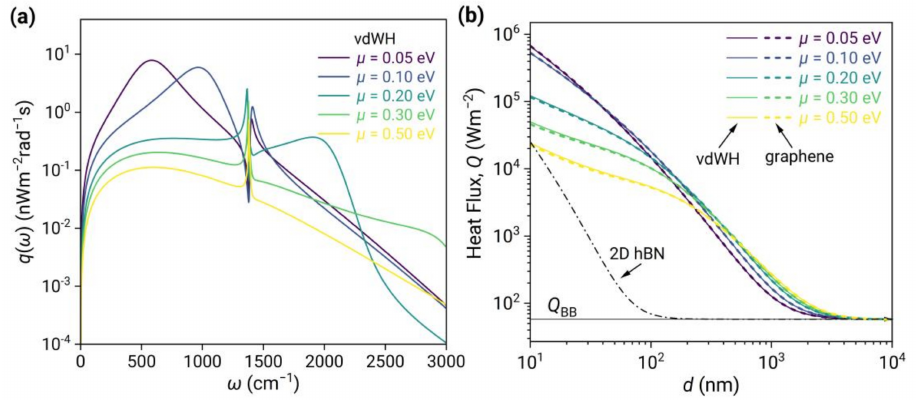
Figure 7. ( a ) Near-field radiative spectral heat flux q ( ω ) of 2D vdW heterostructures at different chemical potentials. ( b ) heat flux Q ( T 1 , T 2 ; d ) as a function of separation for 2D vdW heterostructures (solid curves) and graphene (dashed curves) at different chemical potentials, as well as 2D hBN (dash-dotted curves). The temperatures are 290 K and 300 K,